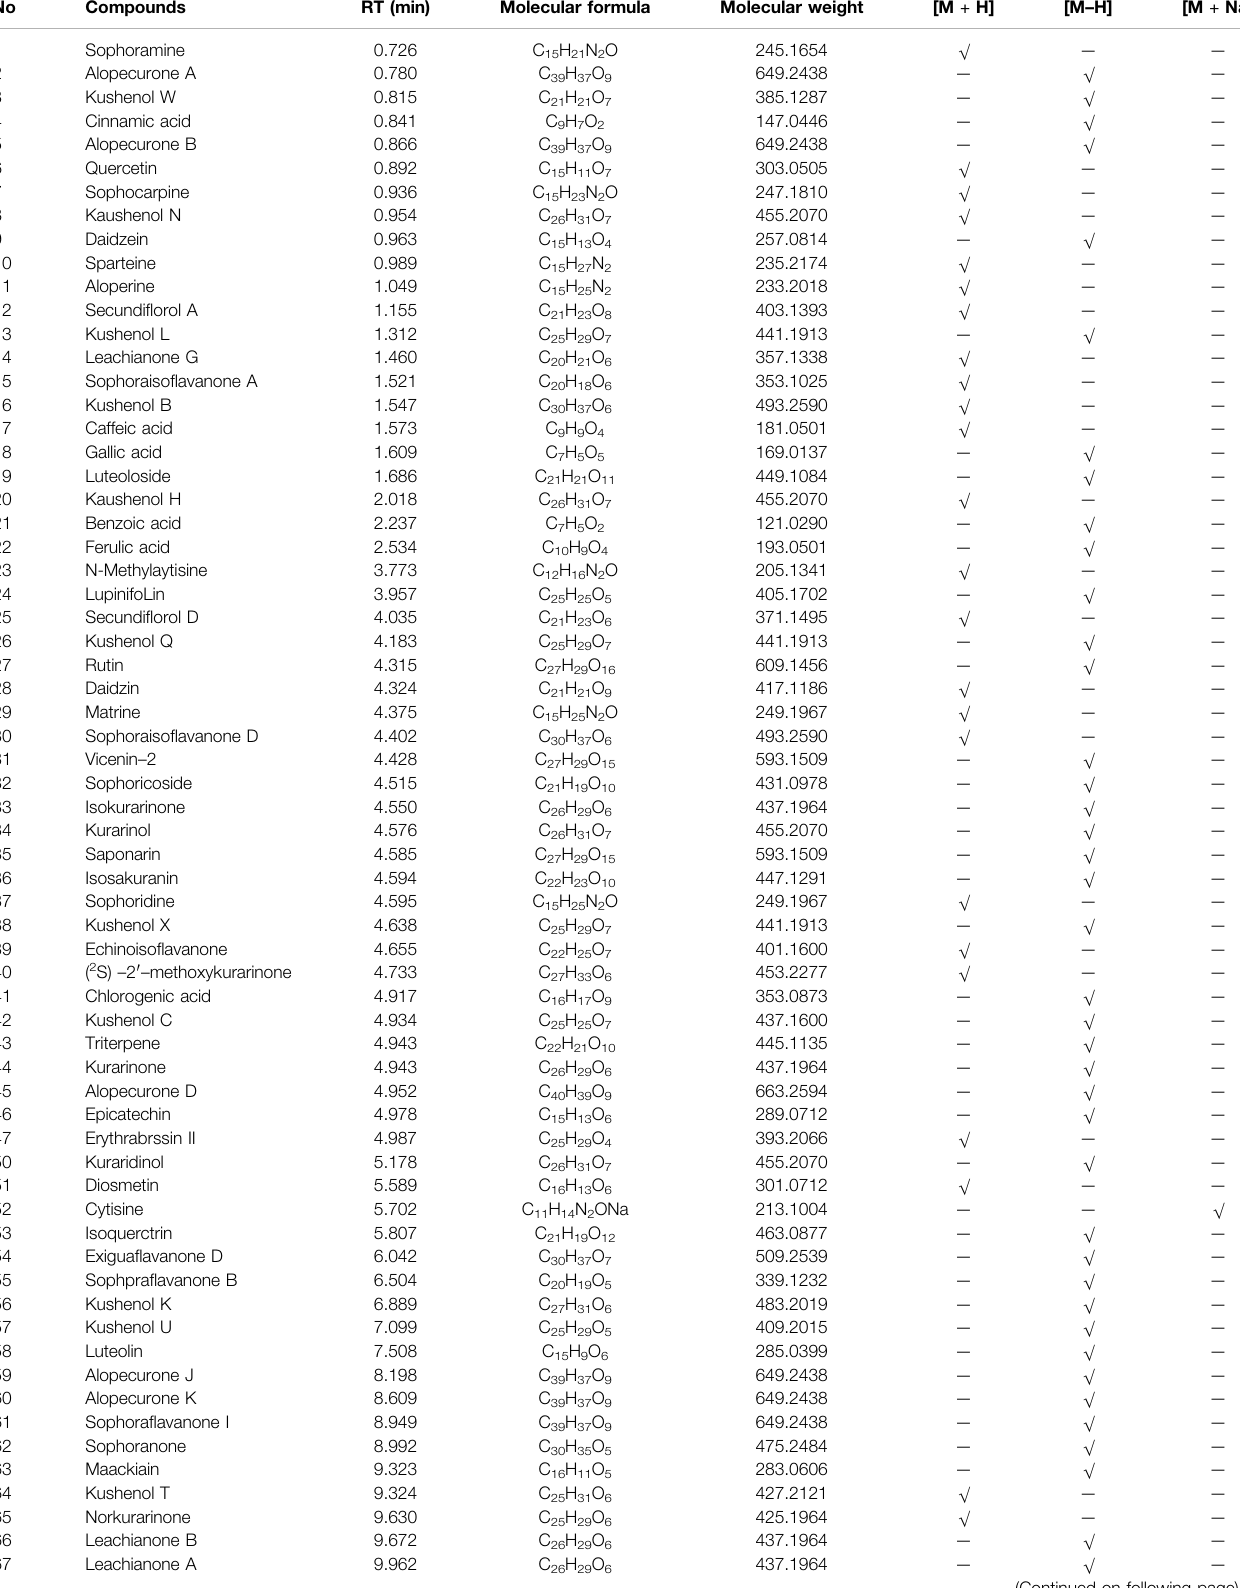
TABLE 2 | The retention time and MS data of 78 compounds in fruit detected by UPLC –